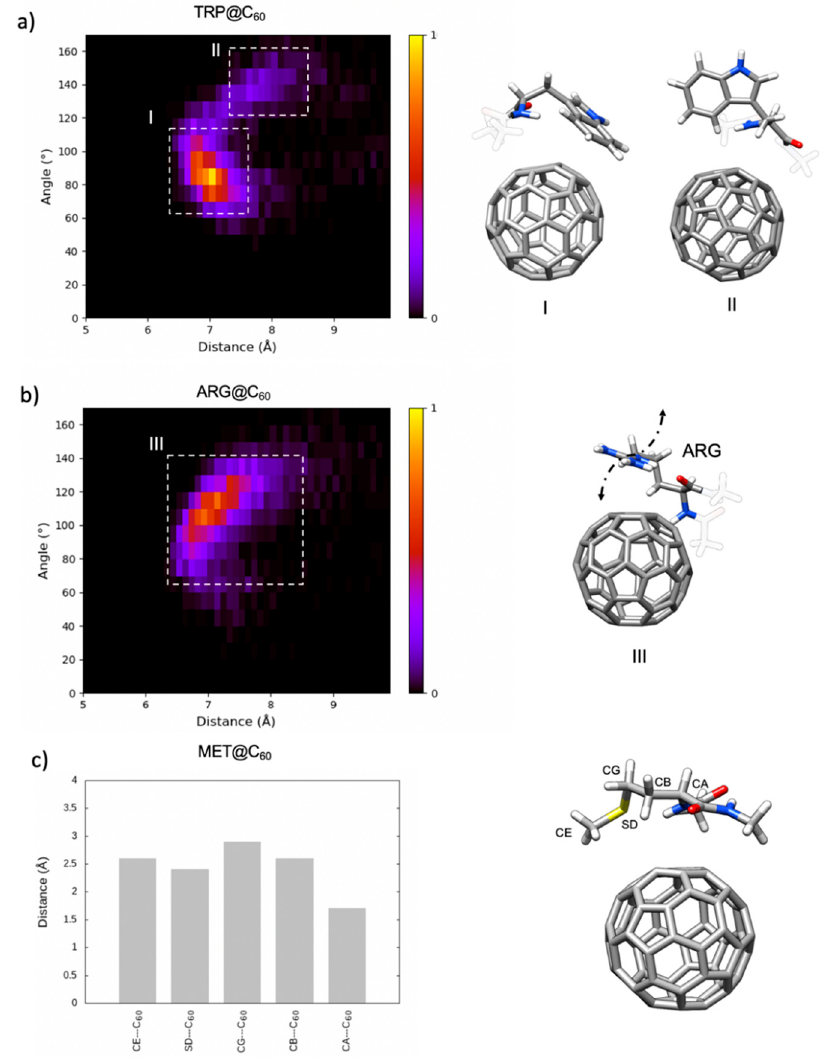
Figure 8. ( a , b ) Normalized free energy surfaces of ( a ) Trp@C 60 and ( b ) Arg@C 60 . In ( a ) the x axis represents the distance between the center of mass (COM) of the indole and the COM of the C 60 . The y axis represents the angle between the (i) COM(C 60 )—COM (indole) and (ii) indole N-H vectors. In ( b ) the x axis represents the distance between the center of mass (COM) of the guanidinium group and the COM of the C 60 . The y axis represents the angle between the (i) COM(C 60 )—COM (guanidinium) and (ii) guanidinium CZ-NH1 vectors. ( c ) Mean distance during the MD simulation between COM (C 60 ) and CA, CB, CG, SD, and CE atoms in Met.